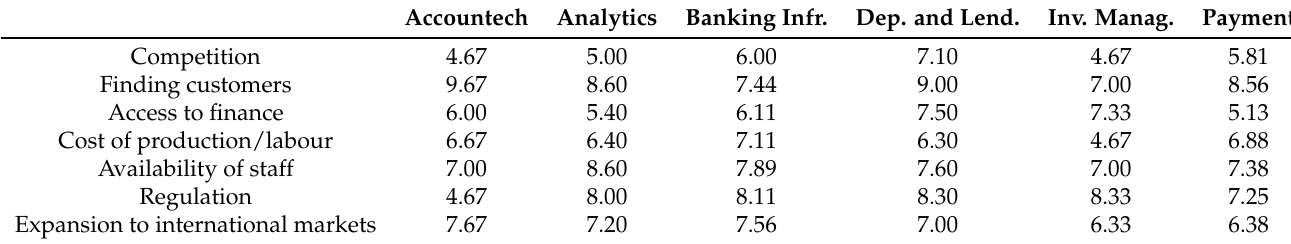
Figure 9. Specific problems and their pressure (means). Table 6. Specific problems and their pressure—by FinTech